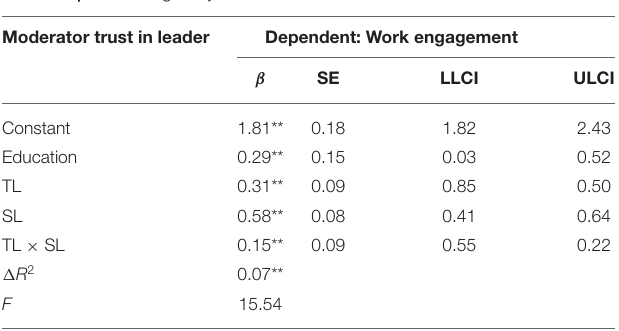
TABLE 5 | Moderating